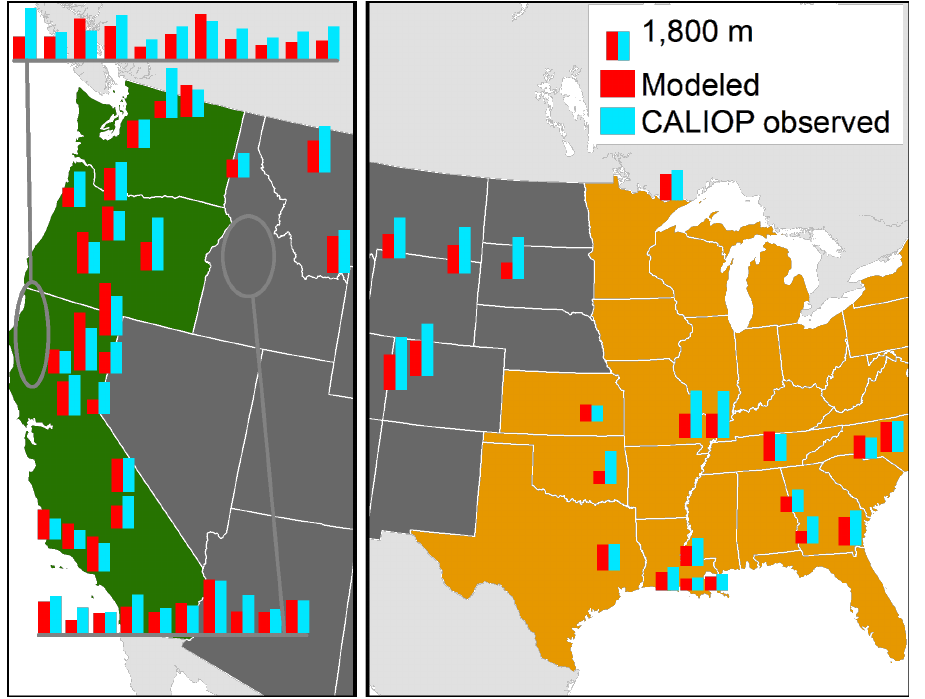
Figure 10. Map of the fire locations used for the comparison of CALIOP observed plume heights (blue bars) to modeled plume heights (red bars). Regions are color coded to match data points shown in Figure